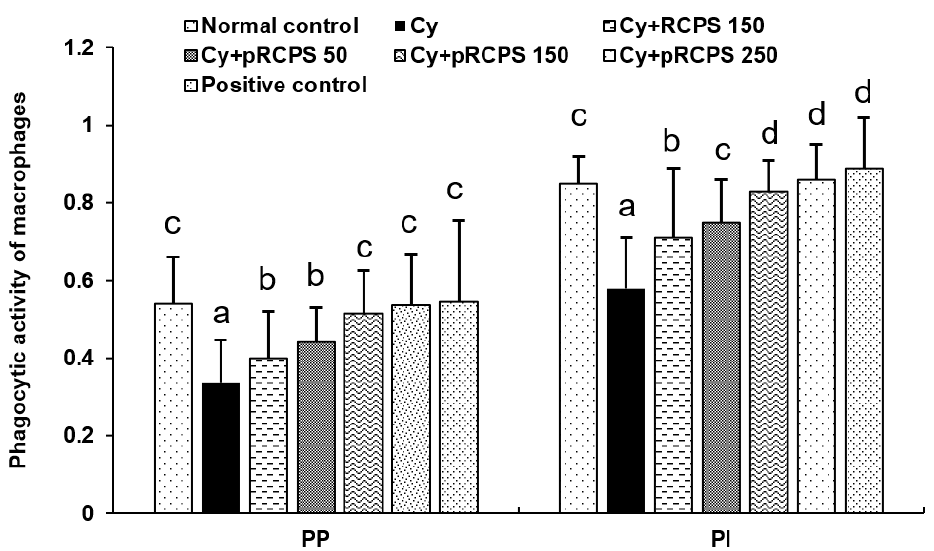
Figure 1. E ff ects of pRCPS on peritoneal macrophages (PM) in Cy-immunosuppressed mice. After 24 h of the last treatment, 1.0 mL of 3% sterilized starch solution was intraperitoneally injected into the mice. After an additional 24 h, 1.0 mL chicken red blood cells solution (1%) were intraperitoneally injected into the mice. 30 min later, one drop of peritoneal fl uid was observed under an optical microscope after placing it on a microscope slide and stained with Wright’s stain. The peritoneal macrophages percent (PP) and peritoneal macrophages percent (PI) were determined. Results are presented as the mean ±SD ( n = 10). The different letters (a–d) on a column differ significantly ( P < 0.05).